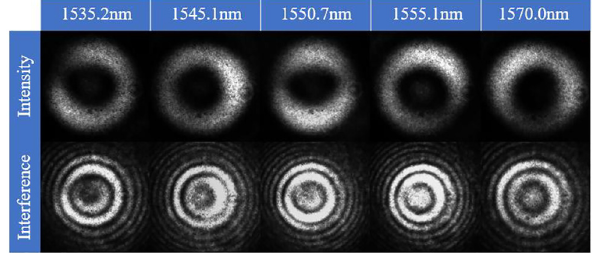
Figure 8: The intensity and interference diagram of output modes of the